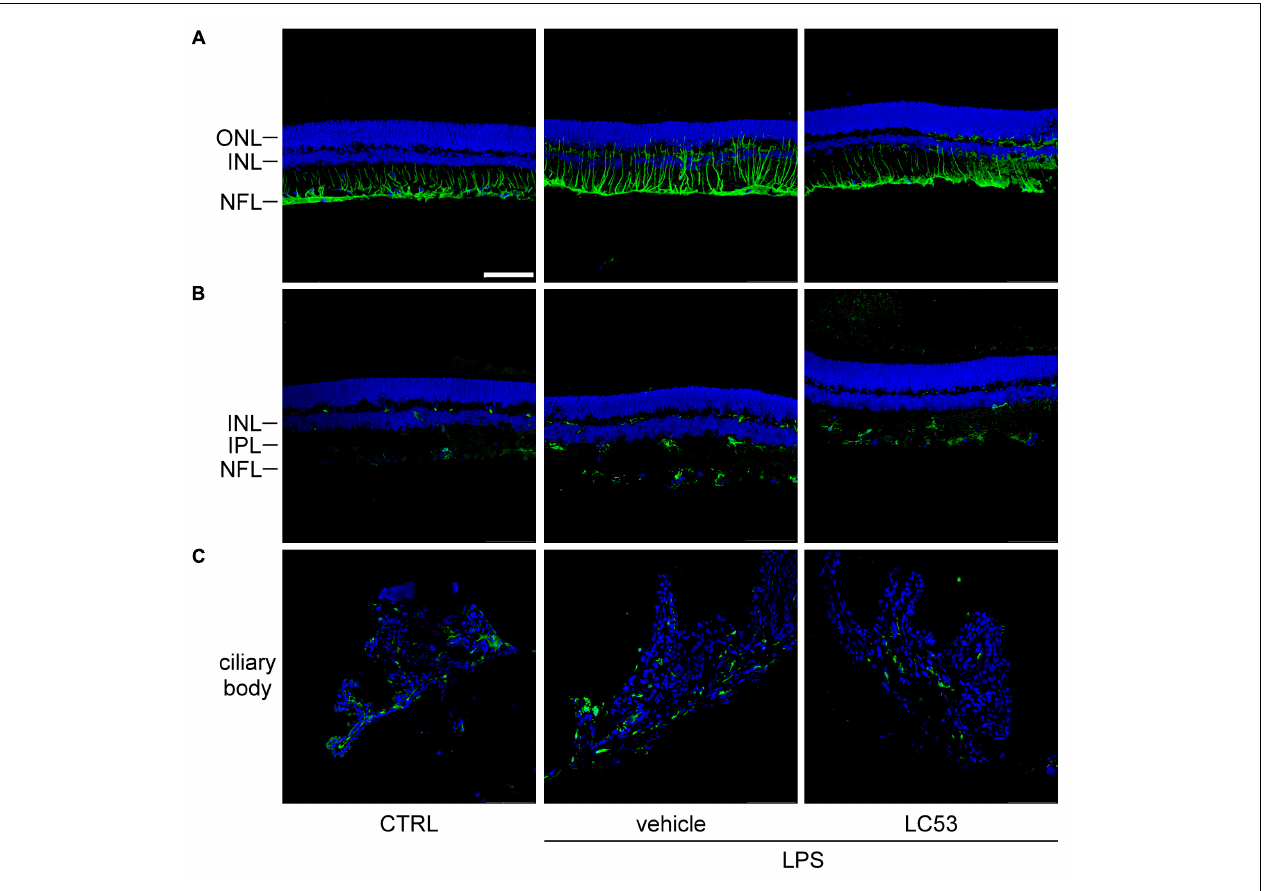
FIGURE 3 | LC53 suppressed the reactivity of Müller glial cells and attenuated the accumulation of monocyte/macrophage in ciliary body and retina section. Representative immunofluorescent images were acquired by confocal from cryo-sectioned eye tissue slices. (A) Activity of Müller glial cells were visualized by GFAP-labeling signal (green) in retinal sections counterstained with DAPI (blue). Distribution of monocyte/macrophage was visualized by Iba-1-labeling signal (green) in retinal sections (B) and ciliary body (C) counterstained with DAPI (blue). CTRL, control; ONL, outer nuclear layer; INL, inner nuclear layer; NFL, nerve fiber layer; IPL, inner plexiform layer. Scale bar: 75 µ